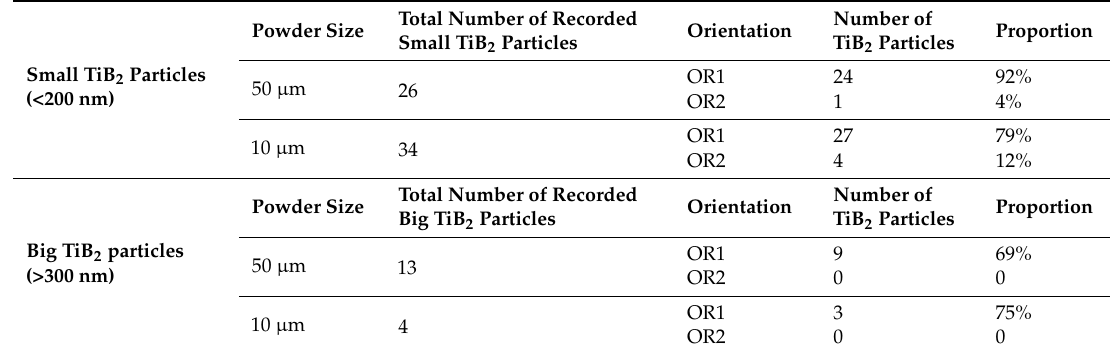
Table 1. Orientation relationship summary of all the recorded TiB 2 particles inside the grain by EBSD.